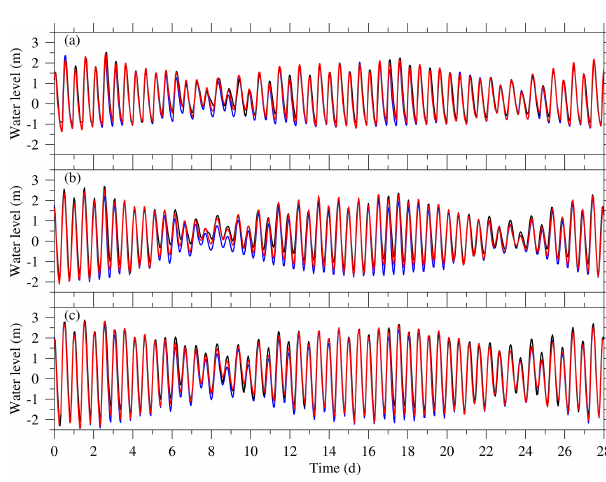
Figure 6. Temporal variations in water levels in February 2014 at hydrologic stations. (a) Baozhen station, (b) Sheshan station and (c) Luchaogang station. Black line – measured data; blue line – simulated data in experiment 1; red line – simulated data in experi- ment